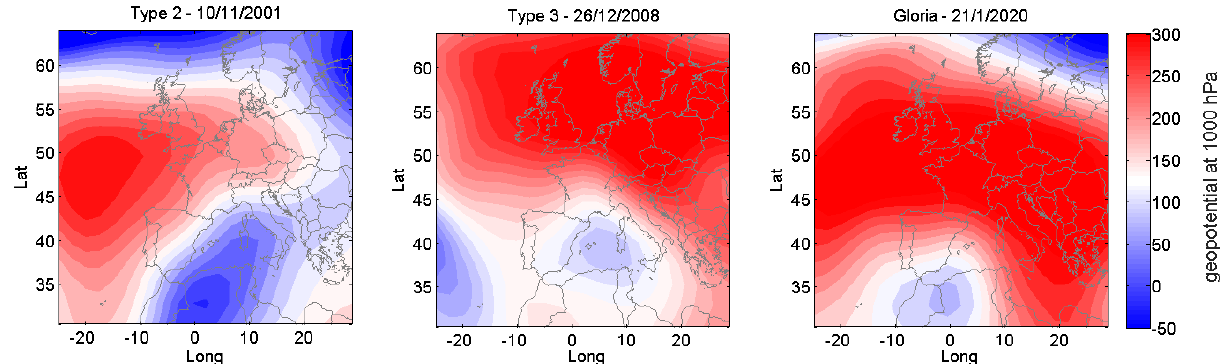
Figure 12. Maps of the 1000hPa geopotential fields (shades) of type 2 and type 3 events extracted at the time closest to the start of the coastal storm. Table 3. Values of the maximum H s (m) and P24h (mm) for each selected event (Figs. 11 and 12) along the study area extracted from the analysis dataset. Data on Gloria (outside the dataset) were extracted from the SIMAR wave database (Puertos del Estado) and XEMA rain gauge system (SMC). Note that the H s values given for Gloria do not belong to the same database as the other storms do; consequently, their values are not absolutely equivalent. Values in bold highlight H s > 5m and P24h > 100mm,